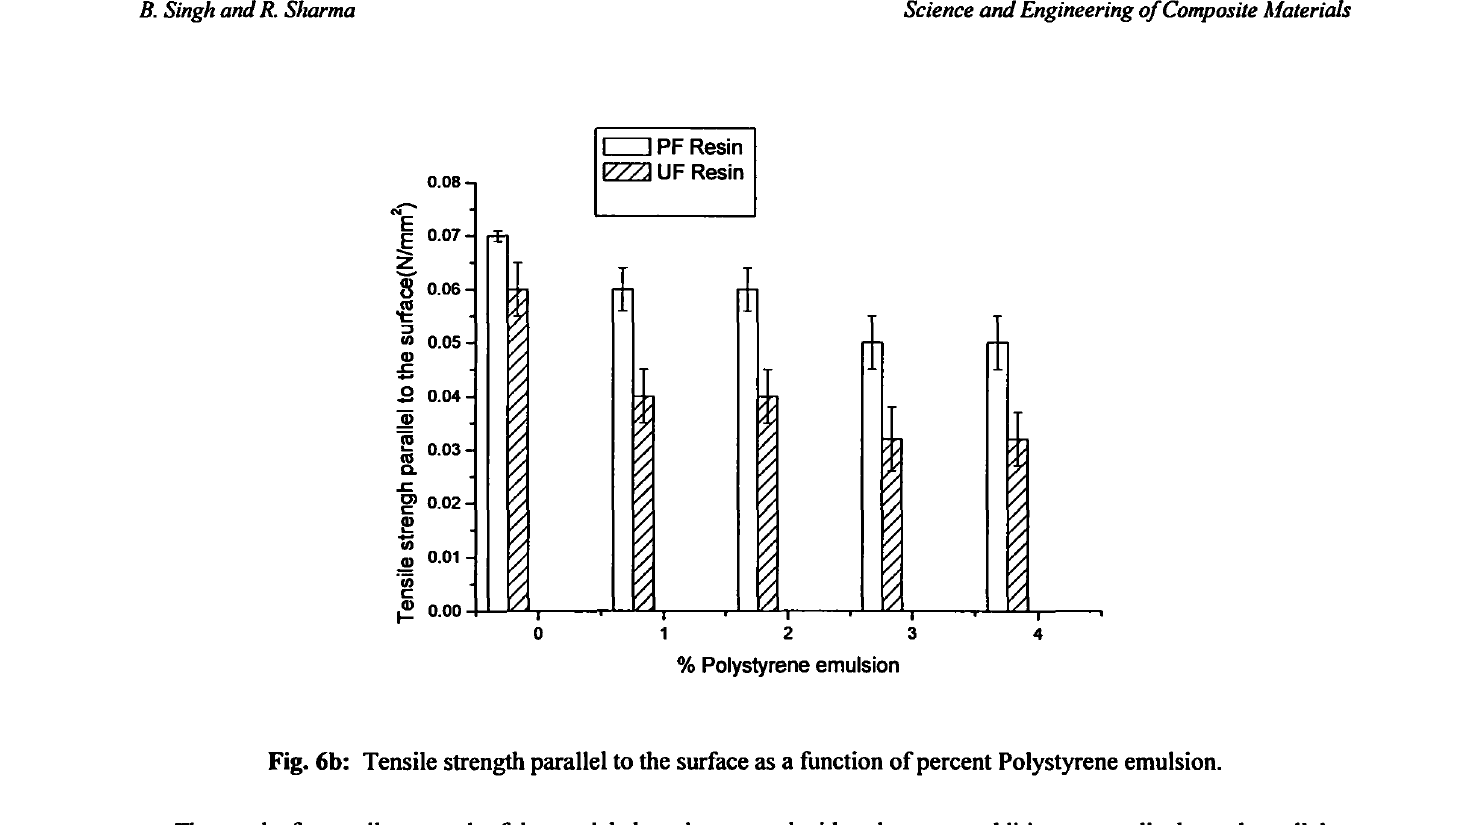
Fig. 6b: Tensile strength parallel to the surface as a function of percent Polystyrene